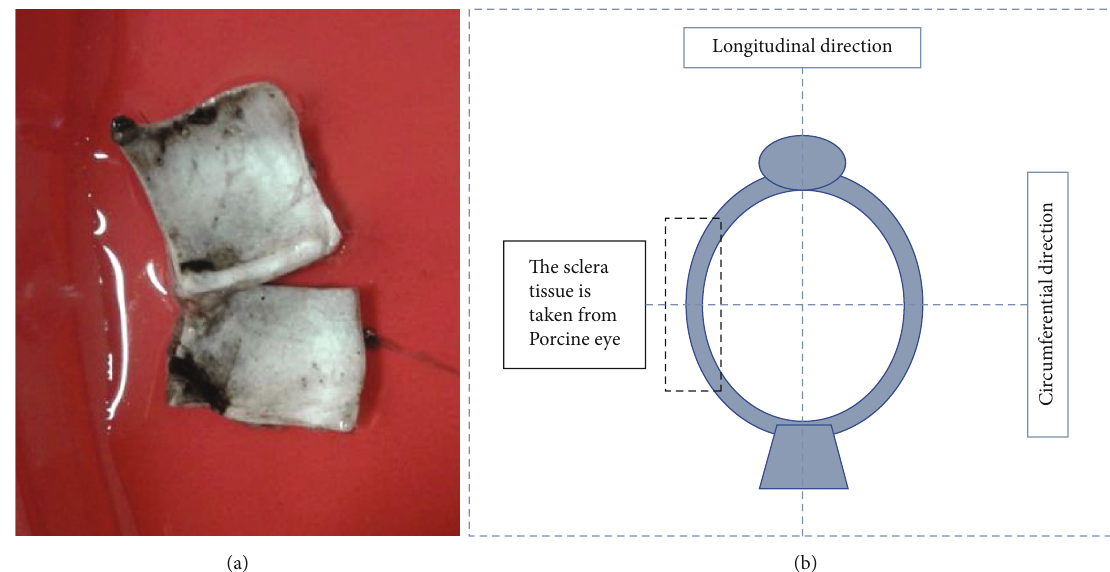
Figure 1: Porcine sclera tissue samples (a) cut from each eye immediately after the delivery from the abattoir to the Unisa Biomechanics Laboratories with a sketch showing how the tissue was excised from the porcine eye (b). The reference axis were de fi ned in such a way that the longitudinal direction is from the cornea to the base while circumferential direction is 90 ° with the longitudinal